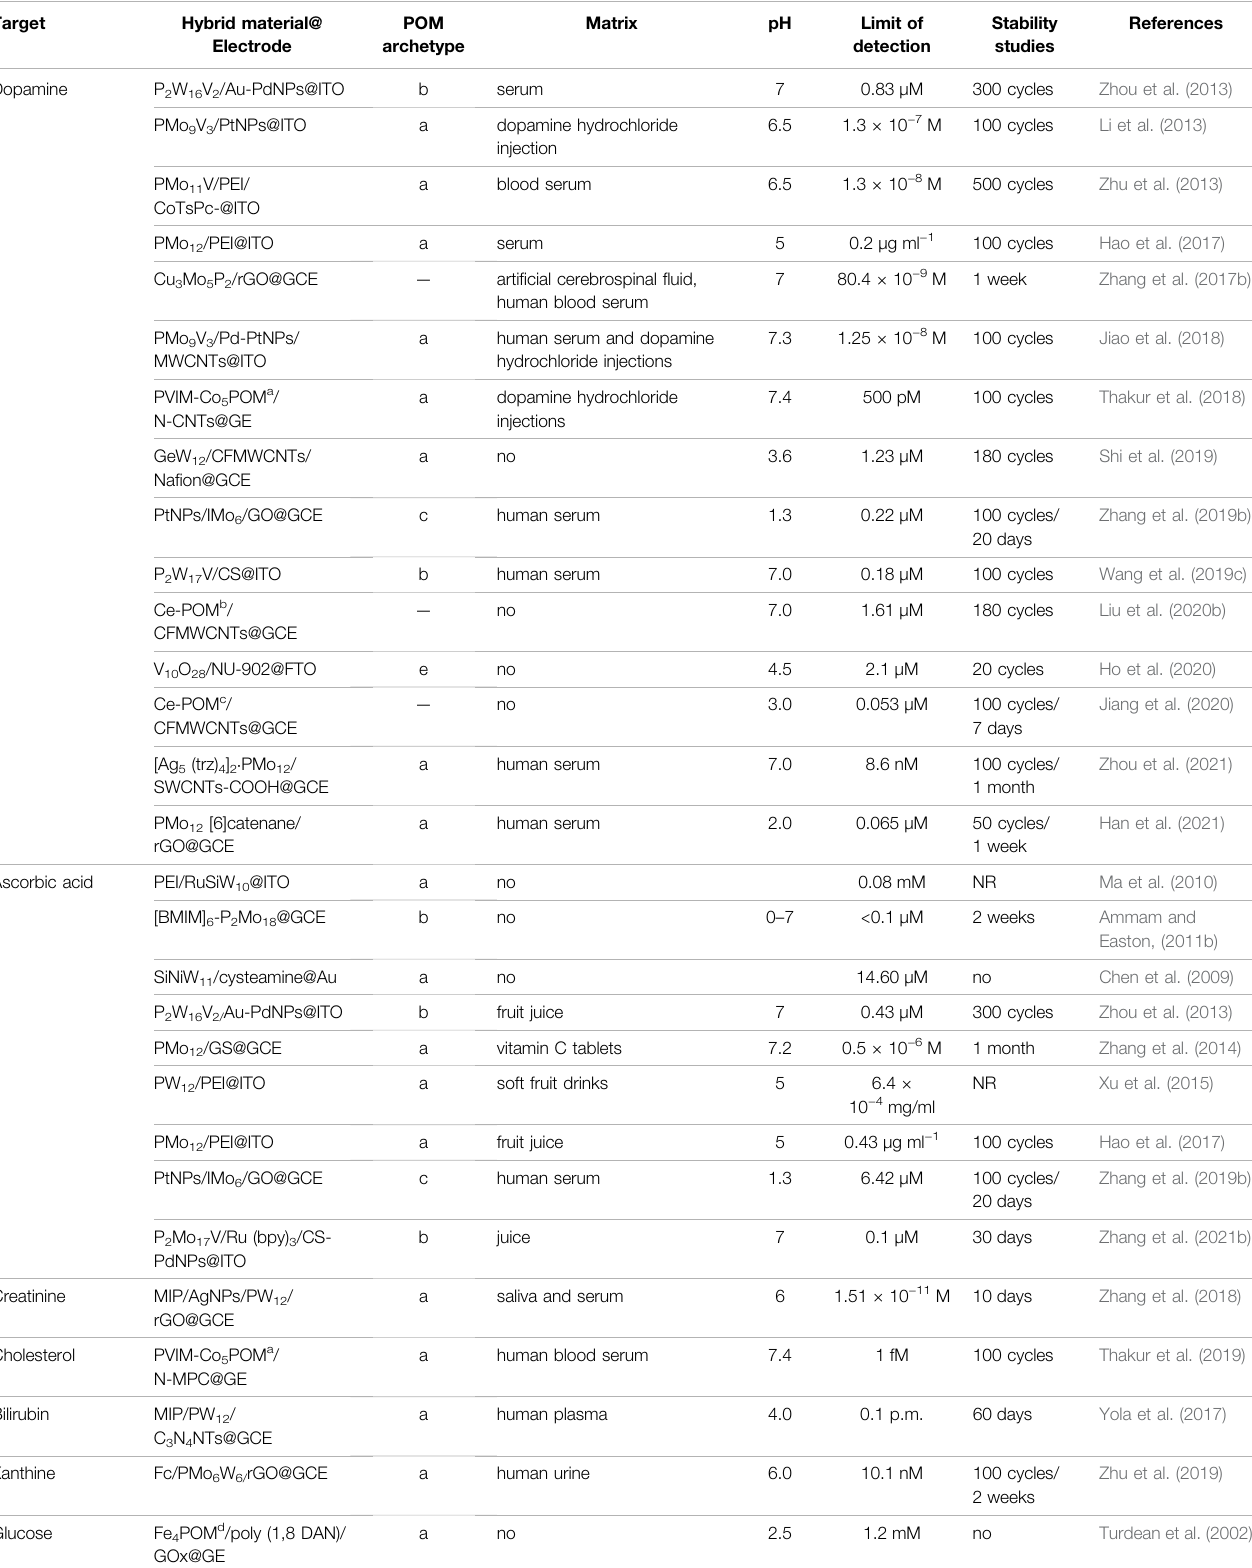
TABLE 4 | POM-based electrochemical sensors for biomolecules and bio-related species.